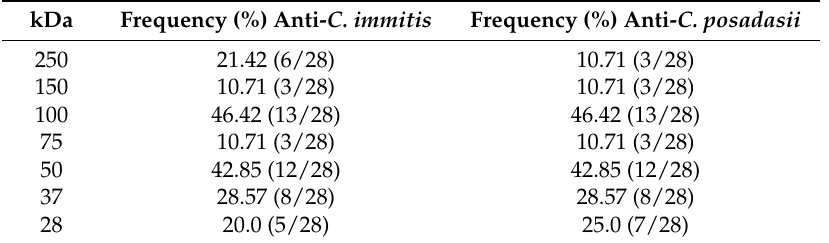
Table 2. Recognition frequency of anti- Coccidioides sera with Coccidioides spp. antigens.